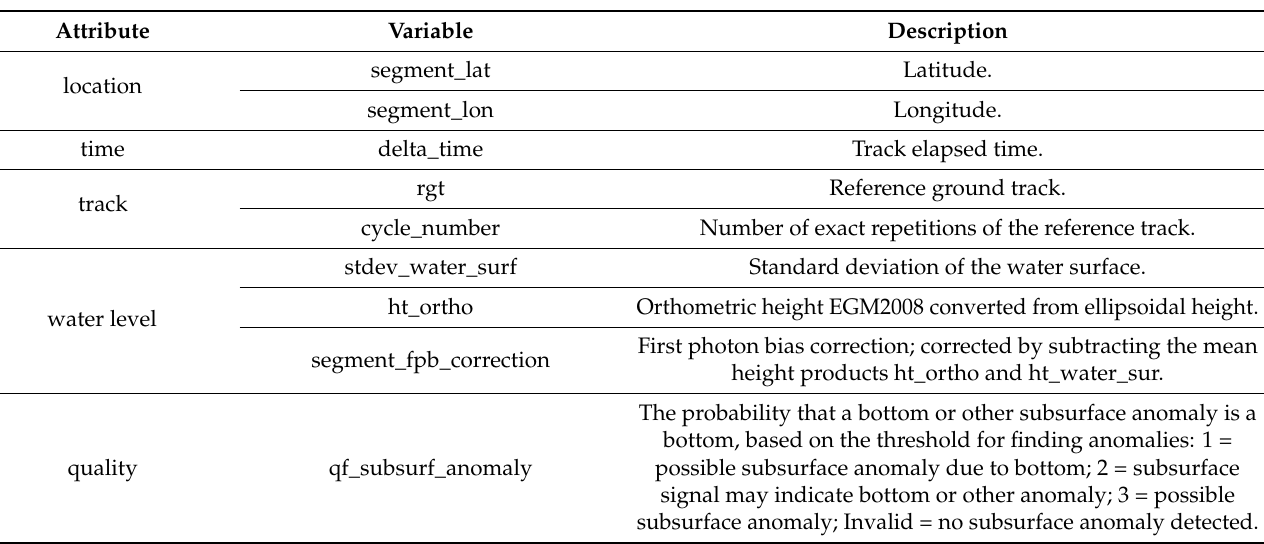
Table 1. ICESat-2 ATL13 data